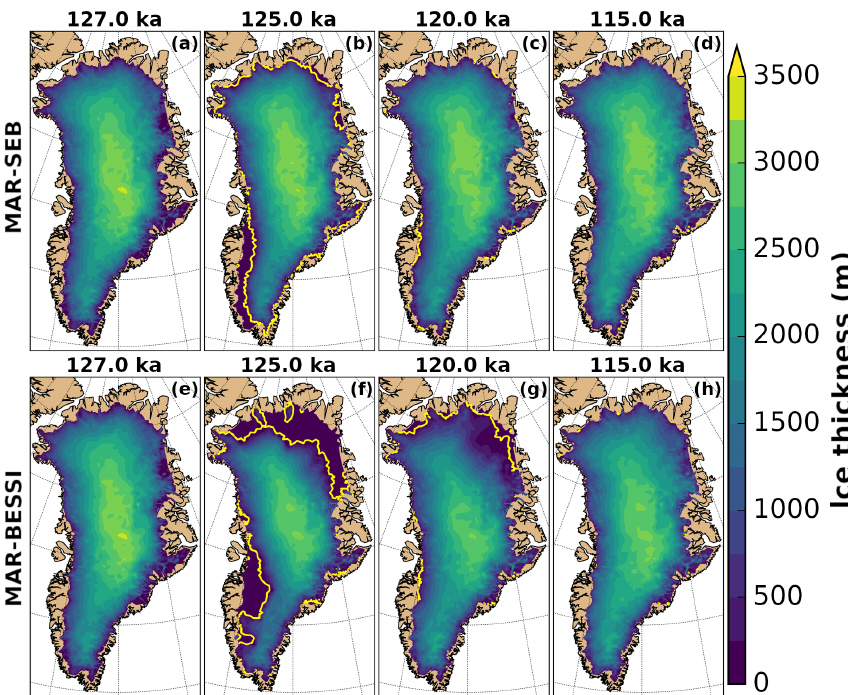
Figure 4. Ice thickness at 127, 125, 120, and 115ka for the control ( a–d , MAR-SEB) and the SMB ( e–h , MAR-BESSI) experiments. The ice margin is indicated with a solid yellow line (10m ice thickness remaining). A nonvisible ice margin is identical to the domain margin. For a consistent comparison, the ice thickness is shown at 125ka instead of the individual minimum ( control at 124.7ka and SMB at